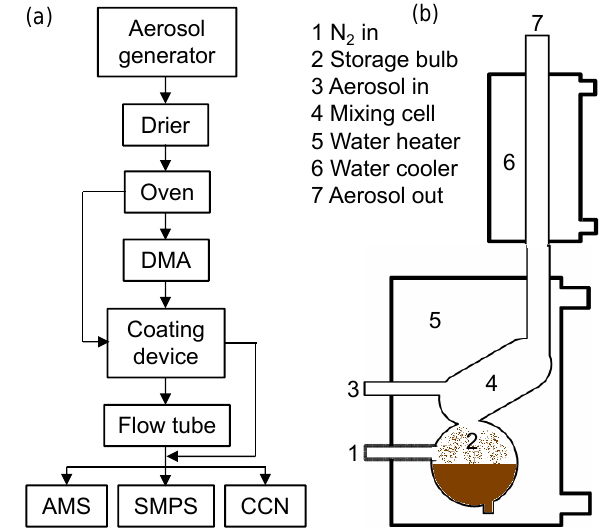
Figure 1. Schematics of the experimental setup (a) . CaCO 3 aerosol is generated by spray-drying saturated Ca ( HCO 3 ) 2 solutions and tempering the aerosol passing through an oven at 300 ◦ C. The poly- disperse CaCO 3 aerosol is either led directly to the coating de- vice ( b , after Roselli, 2006) or led to a differential mobility ana- lyzer (DMA) for size selection first. An optional flow tube can be switched into the pass to enhance the reaction time of the coated par- ticles. The stream of coated particles is finally split to the analytical instruments, namely aerosol mass spectrometer (AMS), scanning mobility particle sizer (SMPS) and CCN